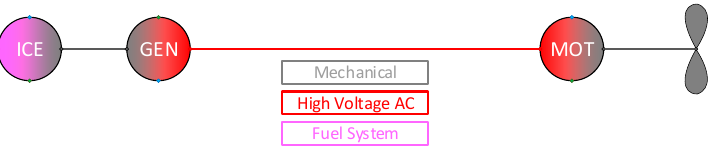
Figure 6. Electric shaft system.